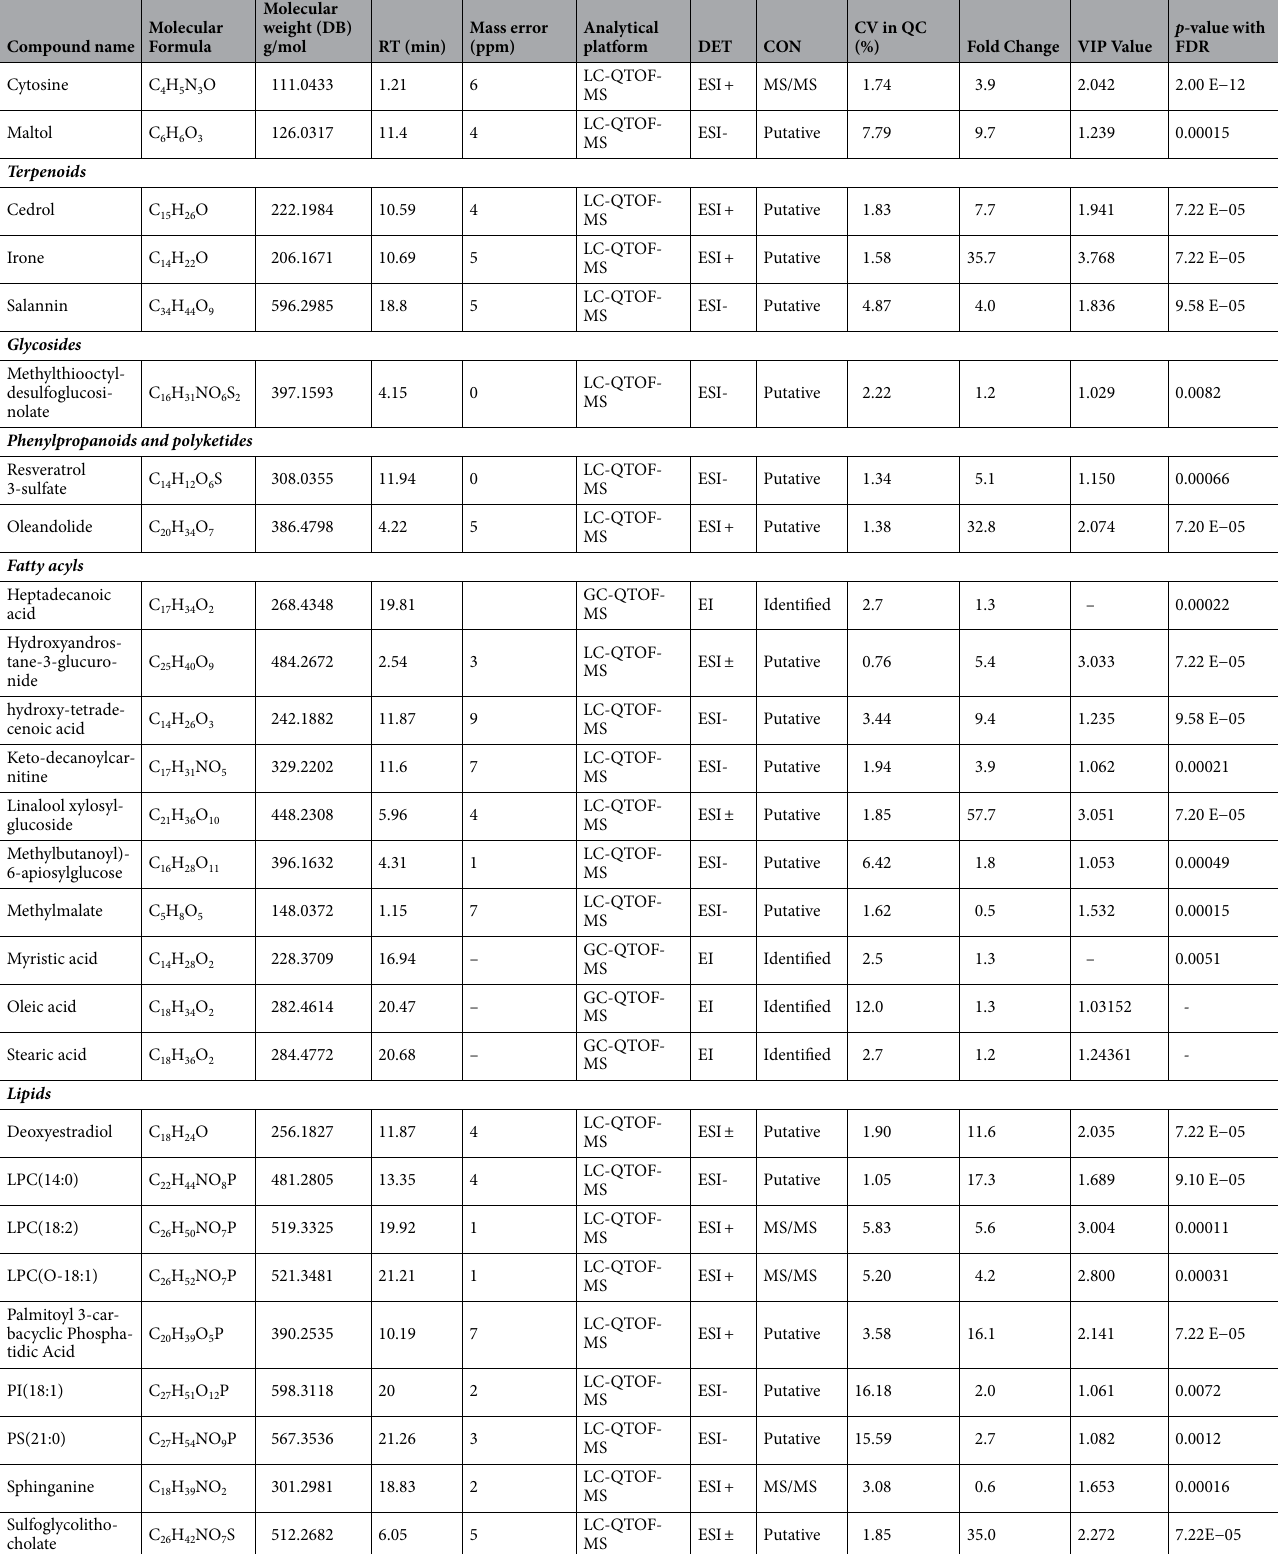
Table 1. Metabolites with statistical significance in the two phases of the fermentation process identified by metabolic fingerprinting using LC-QTOF-MS( ±) and GC-QTOF-MS( +). a DET: detection mode; b CV, coefficient of variation of metabolites in QC samples; c VIP, Variable importance in projection; d CON: Confirmation; e p -value obtained after Benjamini–Hochberg correction test. LC Liquid Chromatography, QTOF-MS quadrupole time-of-flight mass